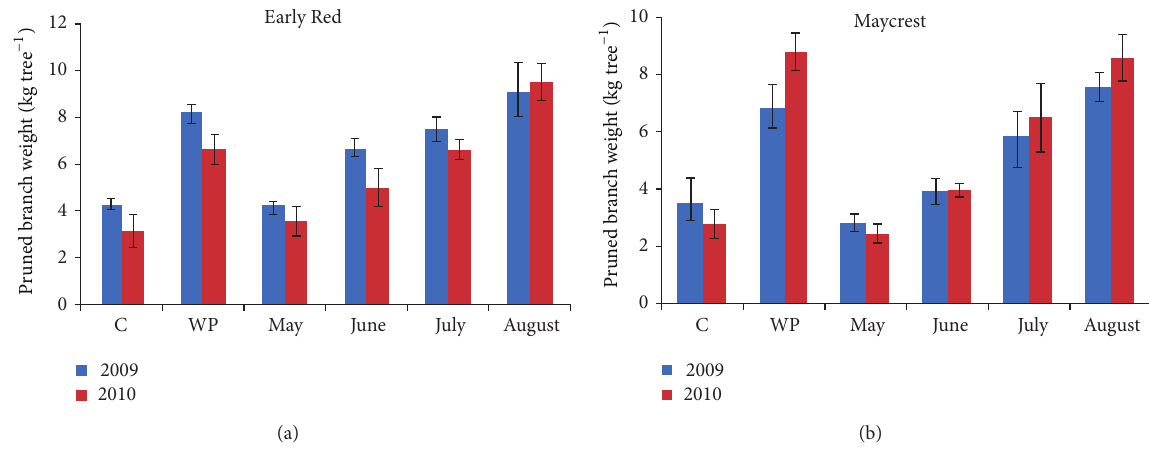
Figure 1: Effect of summer and winter pruning on pruned shoot weight of peach trees in 2009-2010. Vertical bars represent SE ( 𝑛 = 6 ).